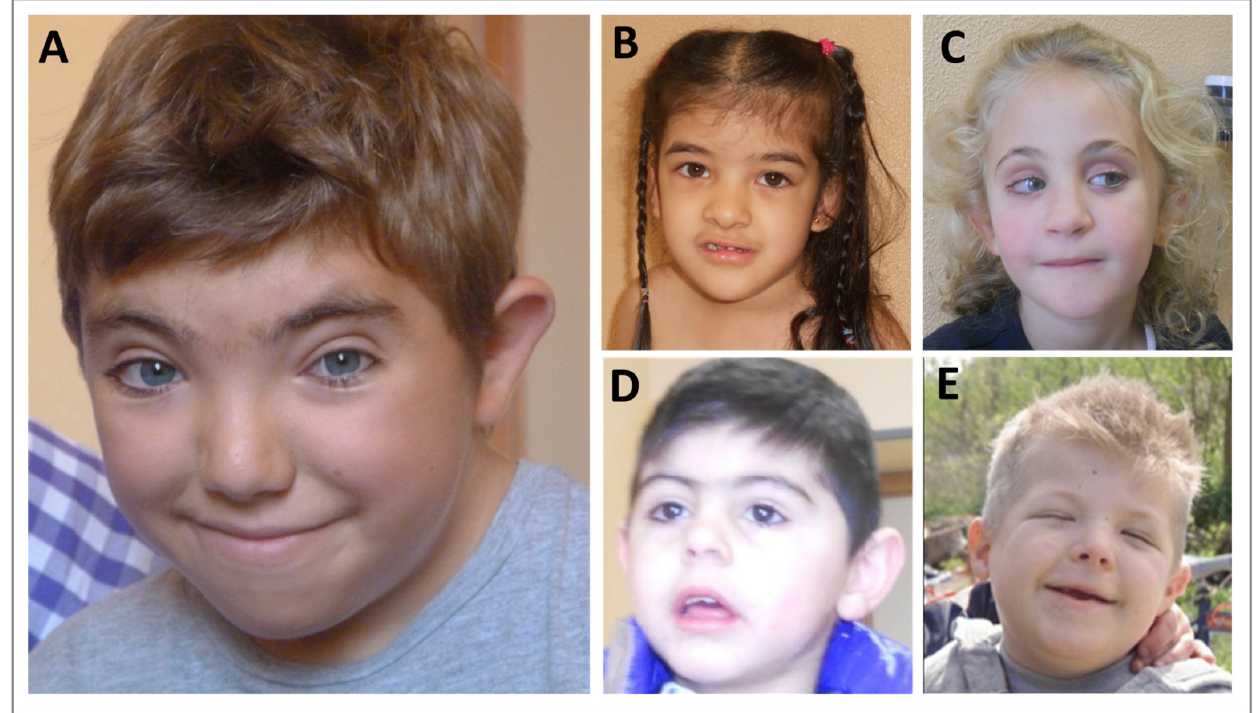
Figure 4. Comparison of typical facial features of ( A ) Wiedemann–Steiner syndrome [26]; ( B ) Coffin–Siris syndrome; ( C ) Kabuki syndrome; ( D ) Cornelia De Lange syndrome [27]; ( E ) Rubinstein–Taybi syndrome [28].